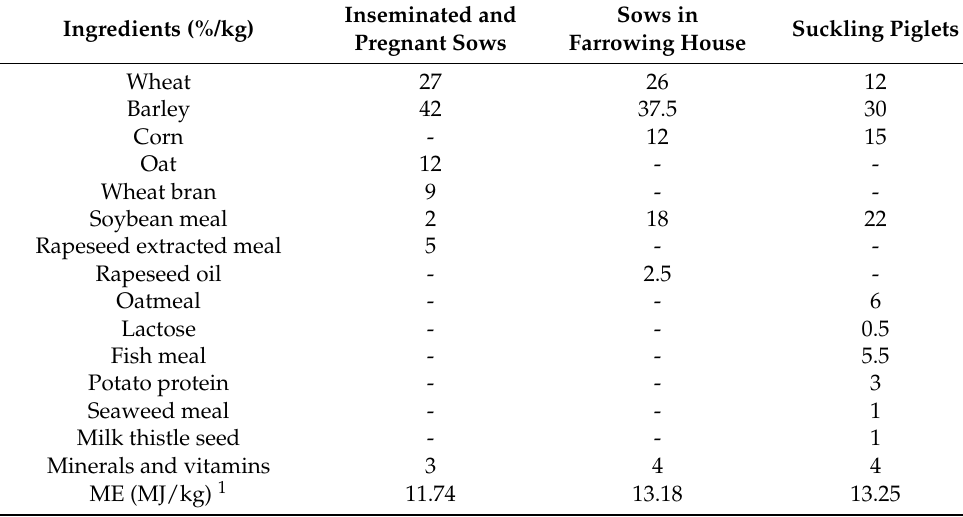
Table 3. Composition of feed mixture for sows and